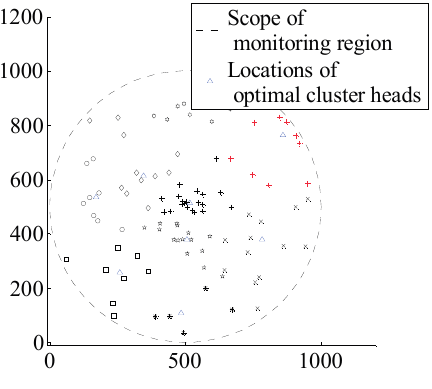
Figure 5. Distribution of clusters when c = 25, N = 1000.